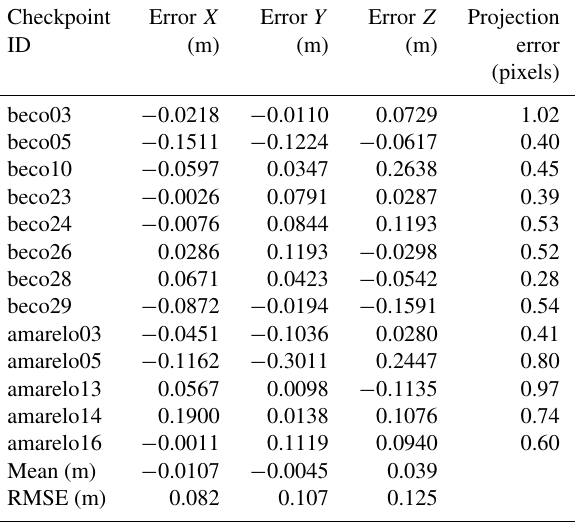
Table 3. Accuracy of the densified point cloud per checkpoint in X , Y and Z